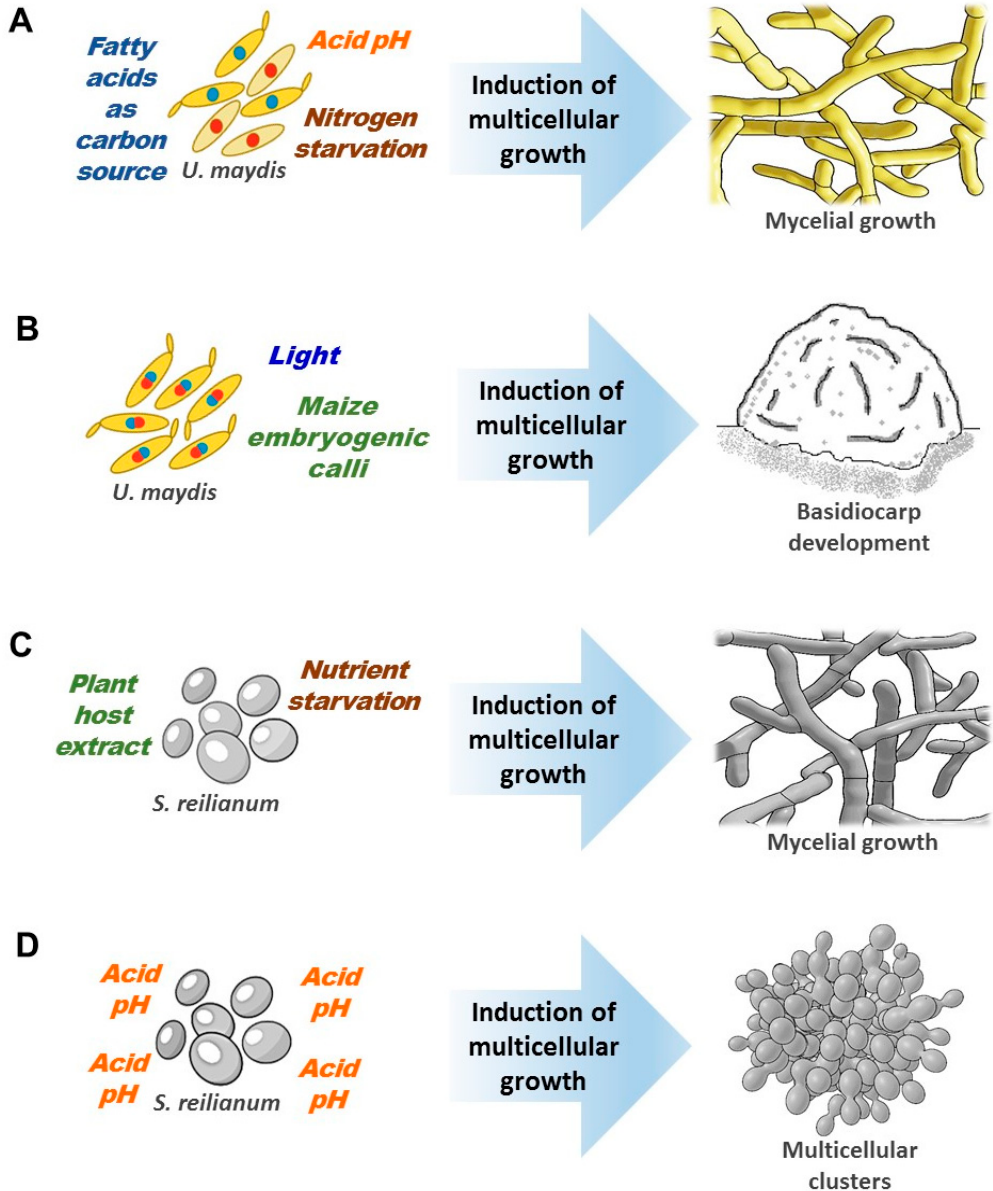
Figure 3. The environmental conditions induce the multicellular growth of Ustilaginomycetes.